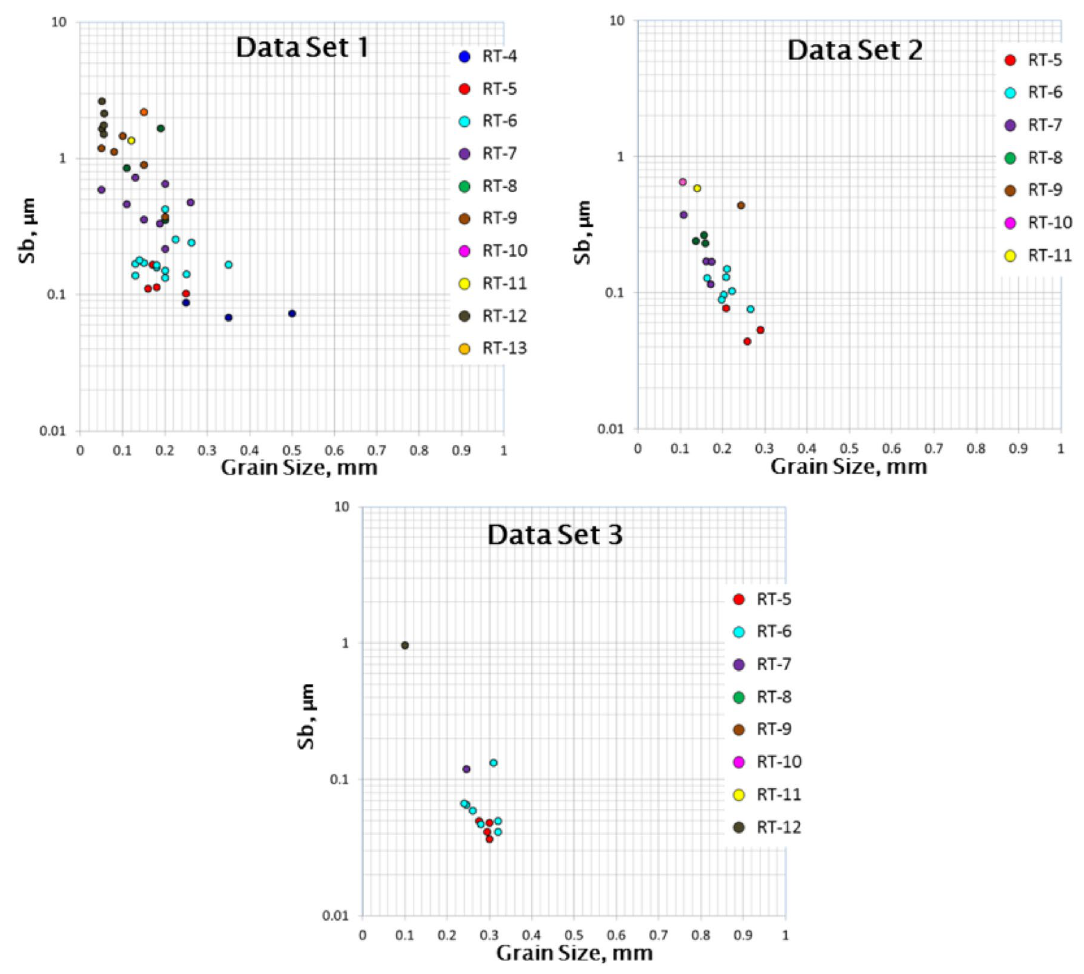
Fig. 4 Relationship of grain size with specific surface